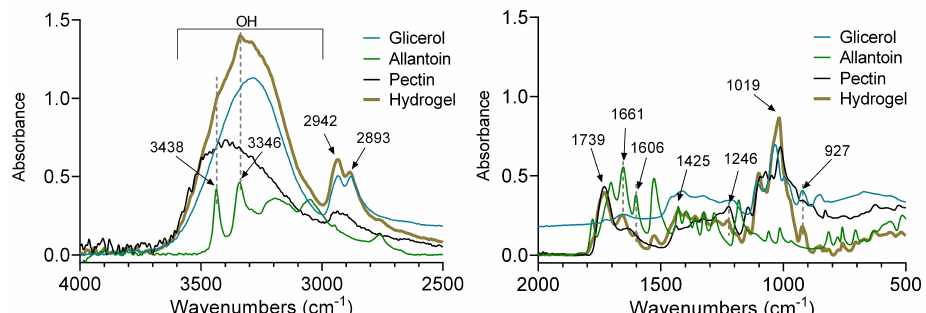
Figure 2. Infrared spectrum of the pectin - allantoin enriched hydrogel. Spectra of pectin, allantoin, and glycerol are included for comparison purposes. Black arrow = characteristic peaks related with functional groups of components.